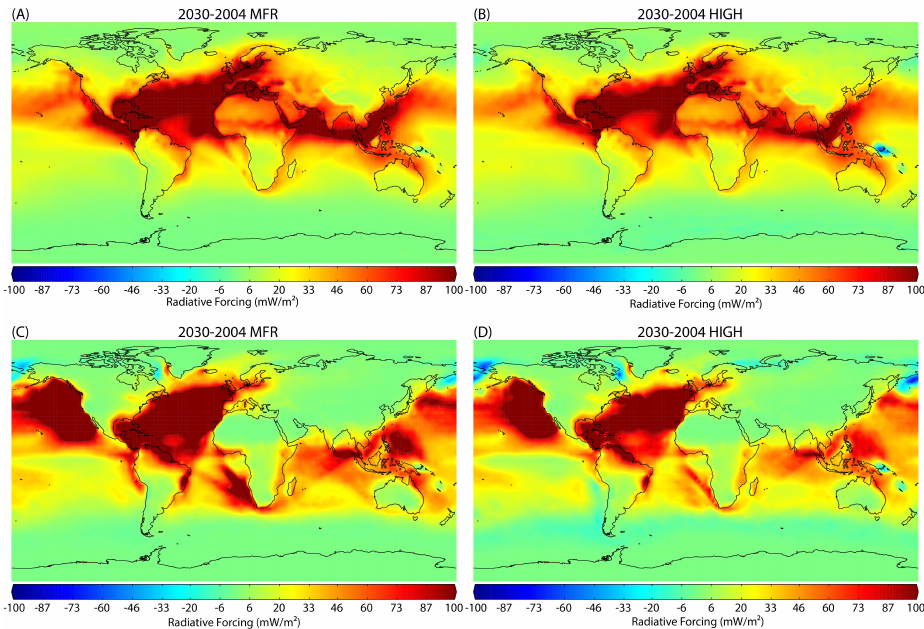
Fig. 10. Yearly mean sulfate direct RF 2004–2030 (mWm − 2 ) for the MFR scenario (A) and HIGH scenario (B) . Yearly mean first indirect aerosol RF 2004–2030 (mWm − 2 ) for the MFR scenario (C) and HIGH scenario (D) .